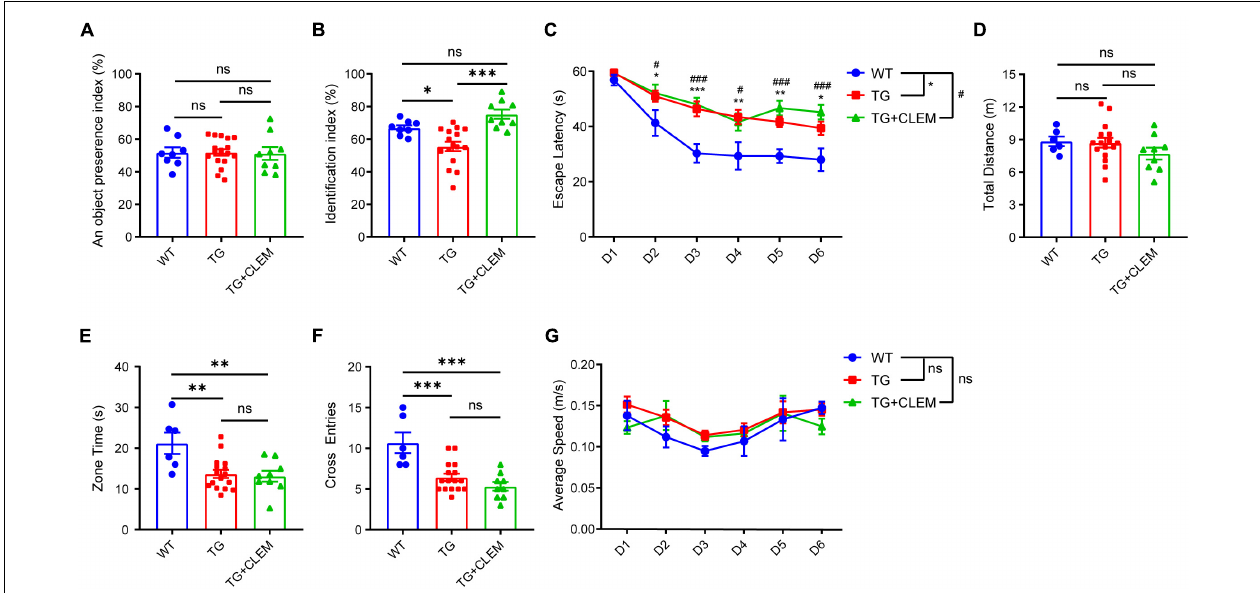
FIGURE 1 | Chronic treatment of clemastine rescues short-term memory deficit of aged APP/PS1 mice. Analyses of mice behavior in novel object recognition test (A,B) and Morris water maze (C–G) . Index of each analysis includes: (A) object preference index, (B) identification index, (C) escape latency, (D) total distance (m), (E) zone time and (F) cross entries, (G) average speed (m/s), should refers to Methods for detail. WT: Wild-type mice. TG: Transgenic mice (APP/PS1). TG + CLEM: Transgenic mice (APP/PS1) treated with clemastine. All tested mice were 17 months old. Values shown represent mean ± SE. ∗ # p < 0.05, ∗∗ p < 0.01, ∗∗∗ ### p < 0.001, n = 8–17 mice per group, one-way analysis of variance with Student’s t